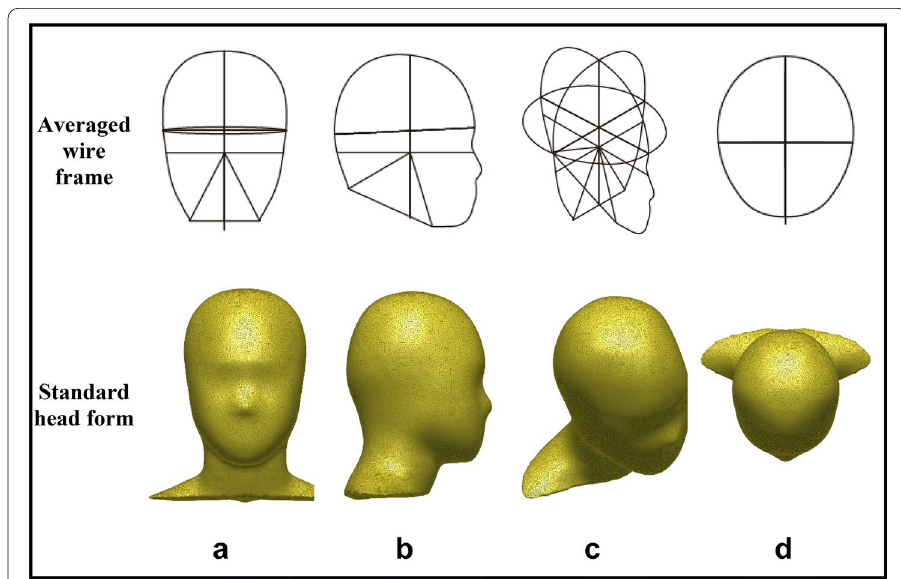
Fig. 2 Results of averaged wire frame generation and standard head form. a Front view; b right view; c SE Isometric view; d top view